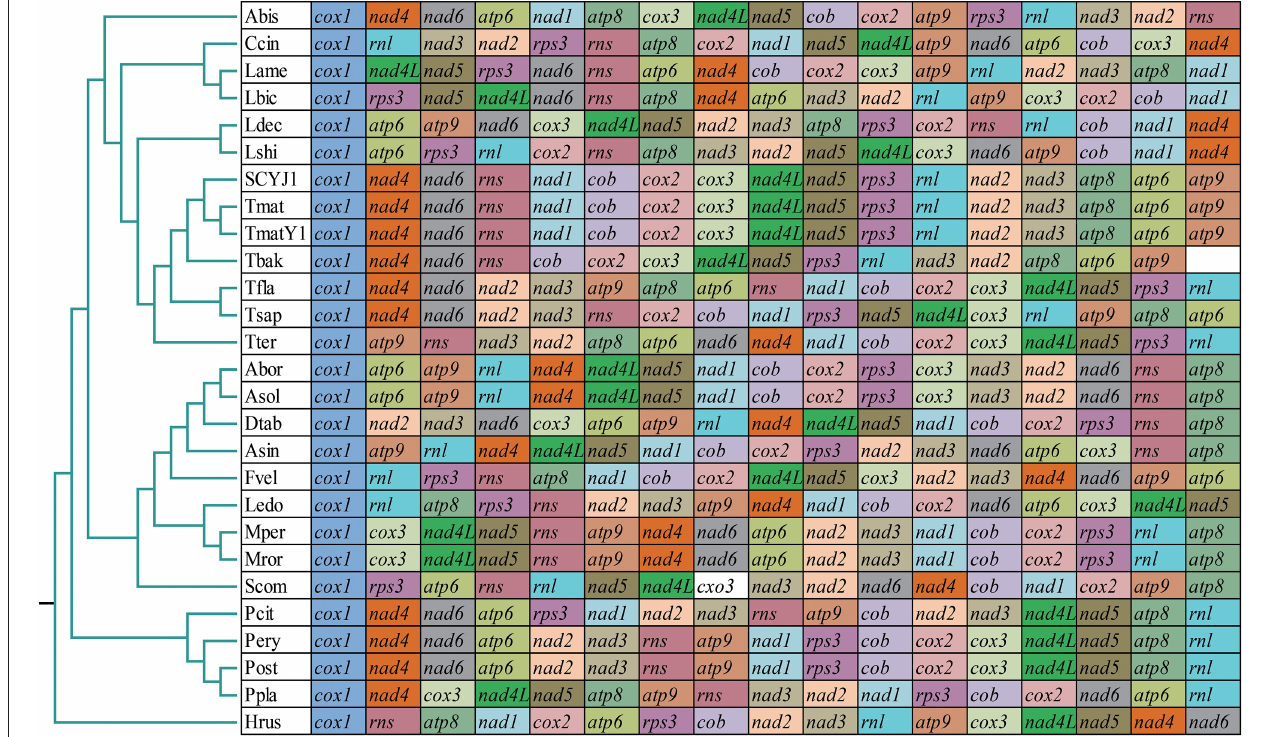
FIGURE 7 | Gene order comparison between 27 Agaricales mitogenomes. Genes are represented with different-colored blocks. All genes are shown in order of occurrence in the mitochondrial genome, starting from cox1 . Fourteen core protein-coding genes, one rps3 gene, and two rRNA genes were included in the gene arrangement analysis. Species and NCBI accession number used for gene arrangement analysis in this study are listed in Supplementary Table 9